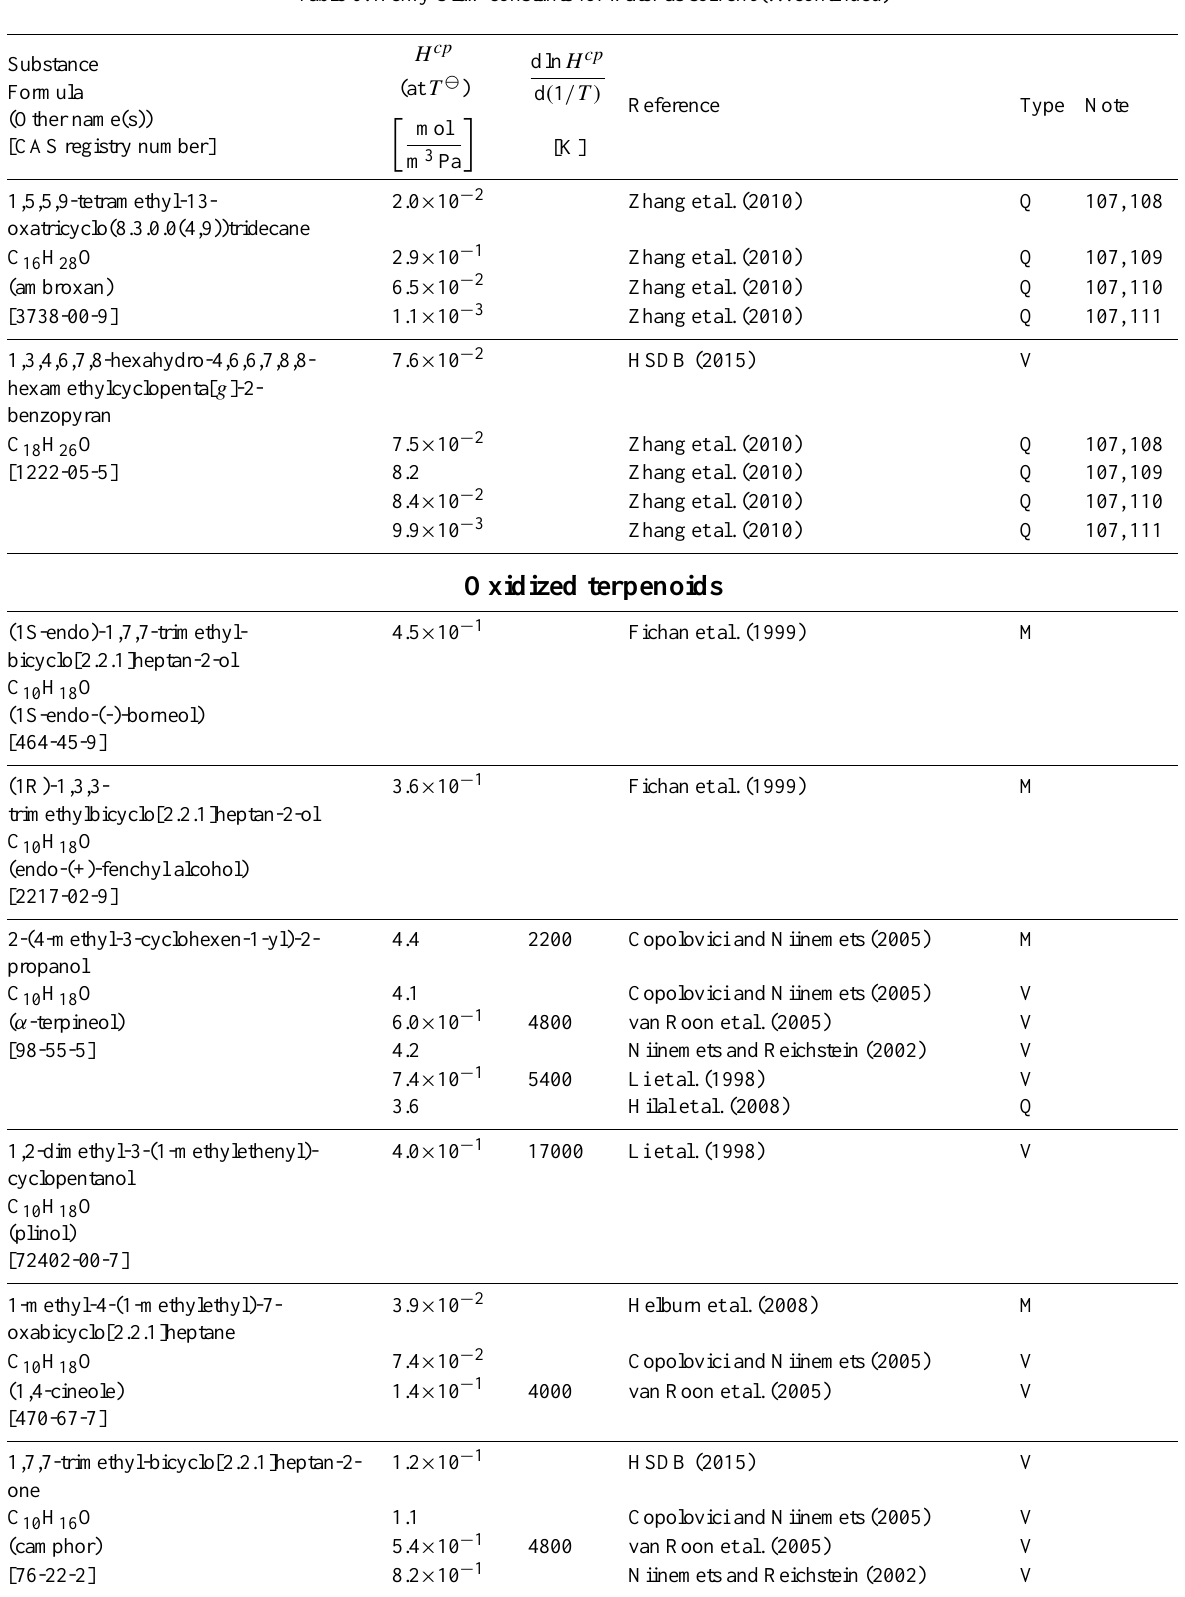
Table 6: Henry’s law constants for water as solvent